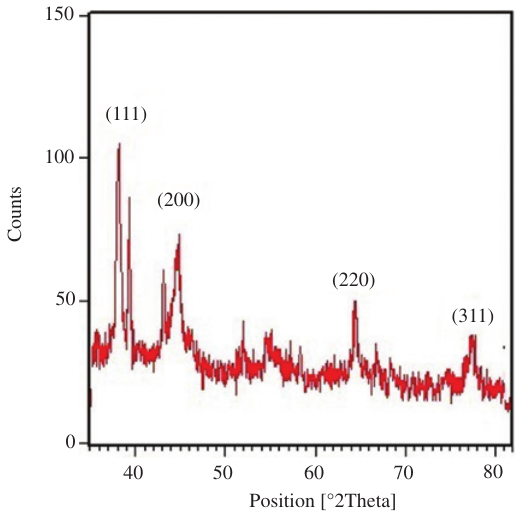
Figure 5: X-ray diffraction (XRD) pattern of silver nanoparticles (AgNPs) obtained by green husk of Juglans regia